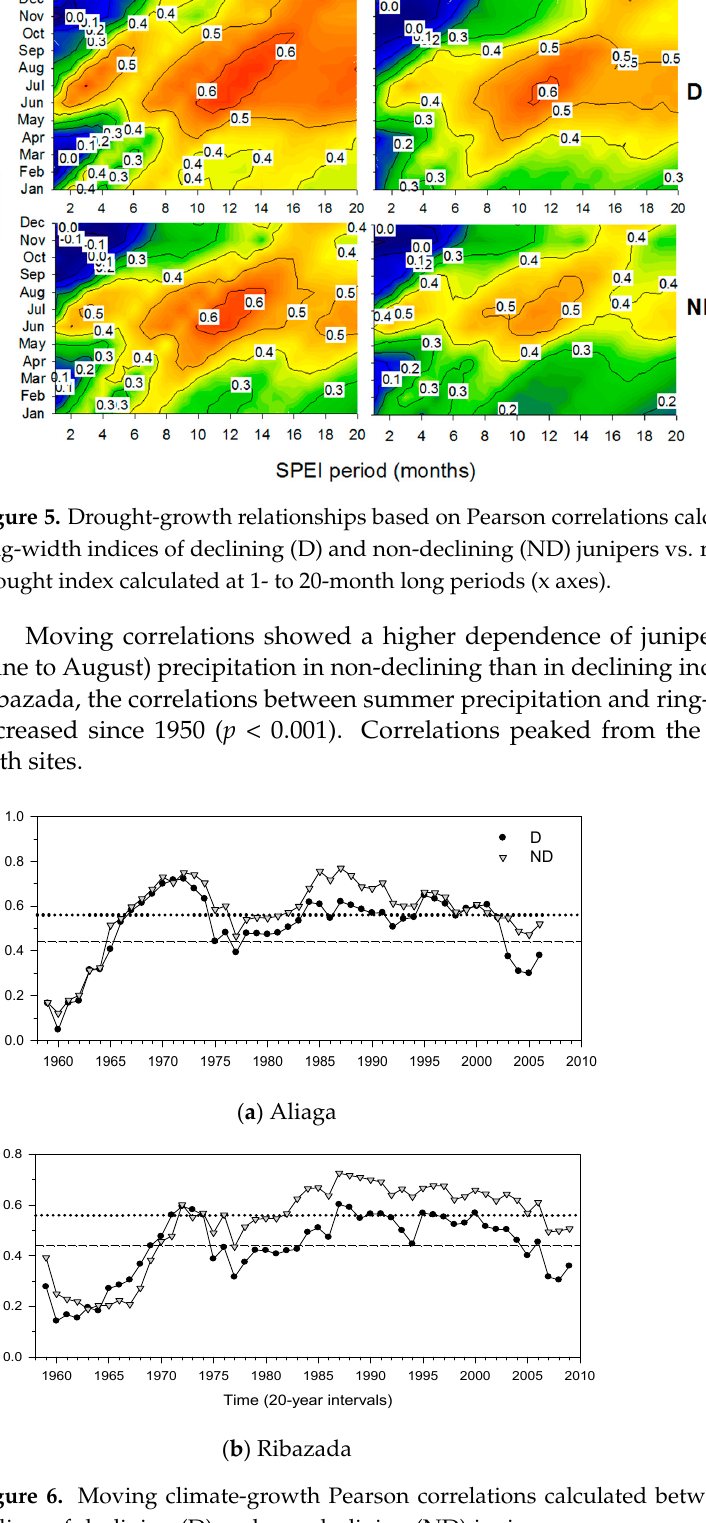
Figure 4. Climate-growth relationships based on Pearson correlations calculated between series of ring-width indices of declining (D) and non-declining (ND) junipers vs. monthly climate variables (Tx, mean maximum temperature; Tn, mean minimum temperature; Pr, precipitation; Sm, soil mois- ture). Correlations were calculated from previous October to current September with months ab- breviated by lowercase and uppercase letters corresponding to the prior and growth years, respec- tively. Dashed and dotted horizontal lines show the 0.05 and 0.01 significance levels, respectively.